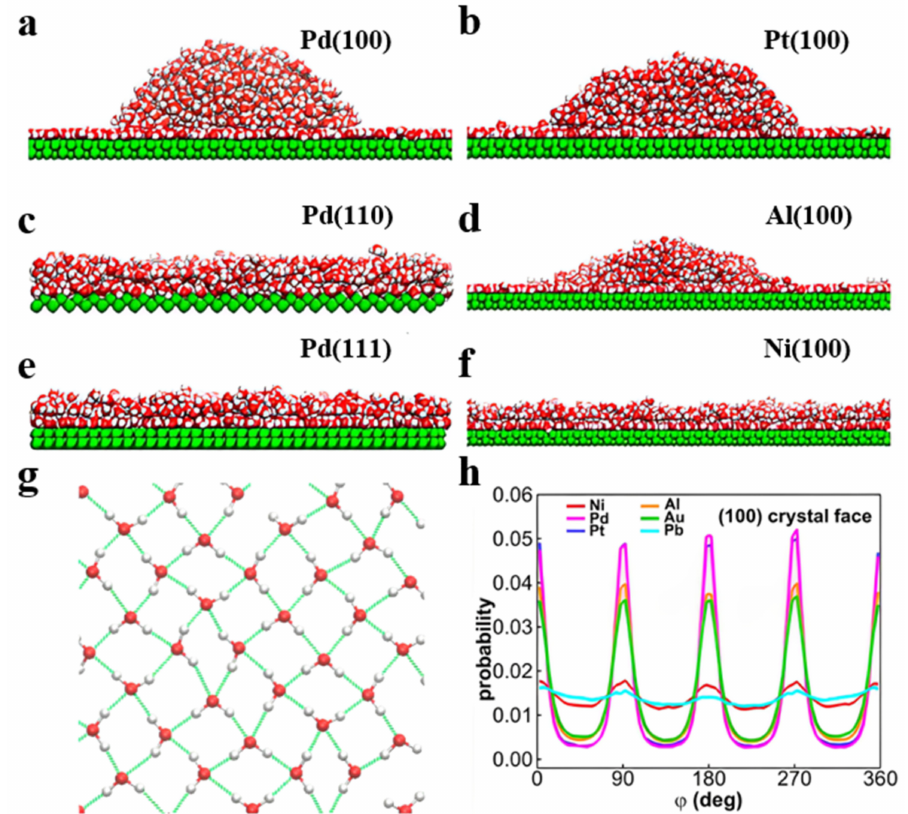
Figure 3. Typical side view of a water droplet on an ordered water monolayer on ( a ) Pd(100), ( b ) Pt(100), and ( d ) Al(100) surfaces, and the spreading water film on some typical surfaces: ( c ) Pd(110), ( e ) Pd(111), and ( f ) Ni(100). ( g ) Snapshot of the ordered, rhombic water molecules (in green lines) forming between neighboring water molecules. ( h ) Probability distribution of angle ϕ between the x–y plane projection of one water molecule dipole orientation and x -axis for (100) the crystal face. (Reprinted from Ref. [107], Copyright 2015 American Chemical